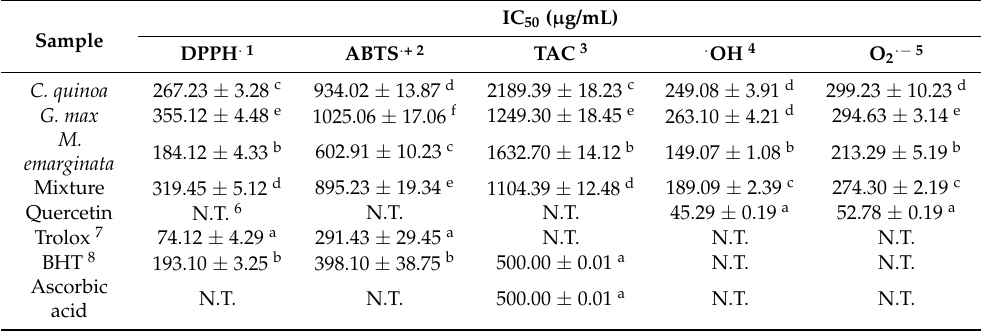
Table 4. Radical scavenging activity of extracts of Chenopodium quinoa , Malpighia emarginata , and Glycine max expressed as the concentration required to eliminate 50% of radicals (IC 50 ).